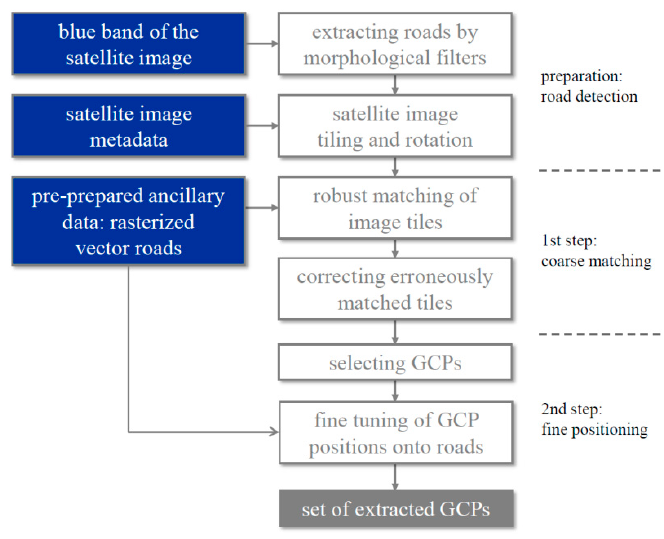
Figure 4. Workflow of the automatic ground control point (GCP) extraction sub-module (the two-step algorithm).